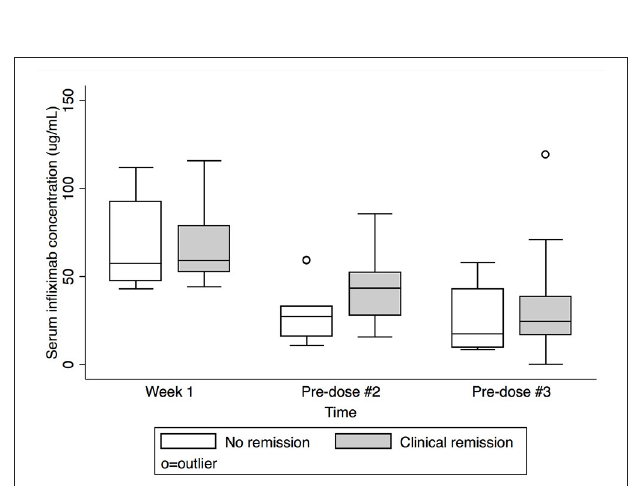
FIGURE 2 | Serum infliximab concentrations at week 1, pre-dose #2, and pre-dose #3 by clinical remission status at Week 8. Box plot values include: lower adjacent value, first quartile, median, third quartile, and upper adjacent value (in ascending order). Lower and upper adjacent values are the most extreme values within the first quartile minus 1.5 × interquartile range and the third quartile plus 1.5 × interquartile range, respectively.